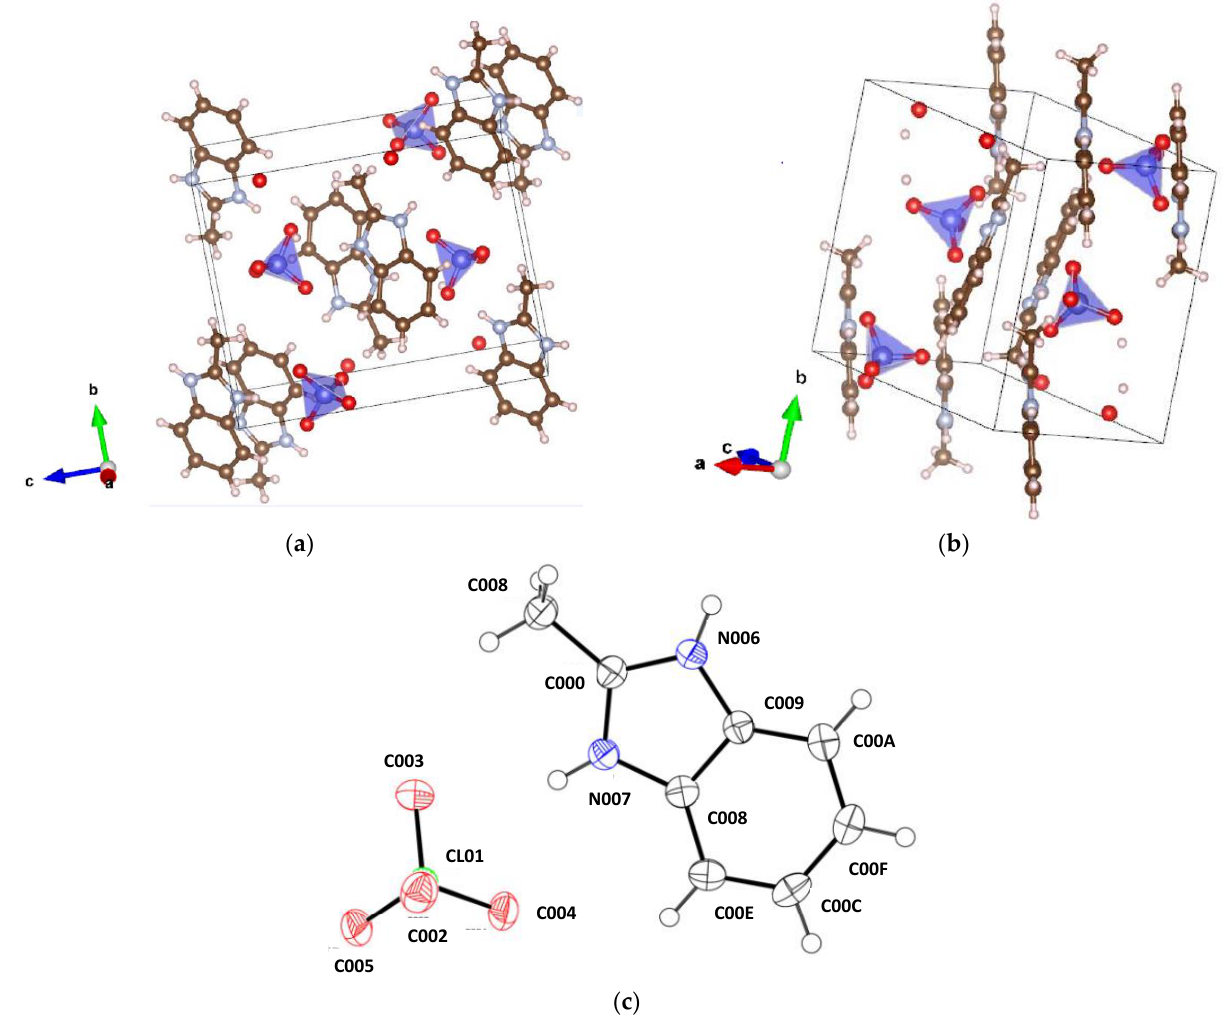
Figure 2. Images of MBI-perchlorate crystal structure ( a , b ). Perchlorate acid tetrahedra are marked by blue, red circles — O, brown circles — C, blue circles — N, open circles — H. ( c ) Perchloric acid and MBI molecule in MBI-perchlorate structure with atoms represented by thermal ellipsoids by means of program ORTEP [56] using the data presented in Tables S1 ̶ S2 and S3 ̶ S4, correspondingly. Table 2. Bond lengths and angles of MBI molecule in crystals with and without